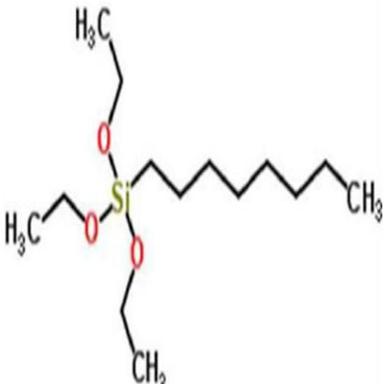
Heat flow generated by a) CEMI-based mortars and b) CEMIII/A-based mortars.